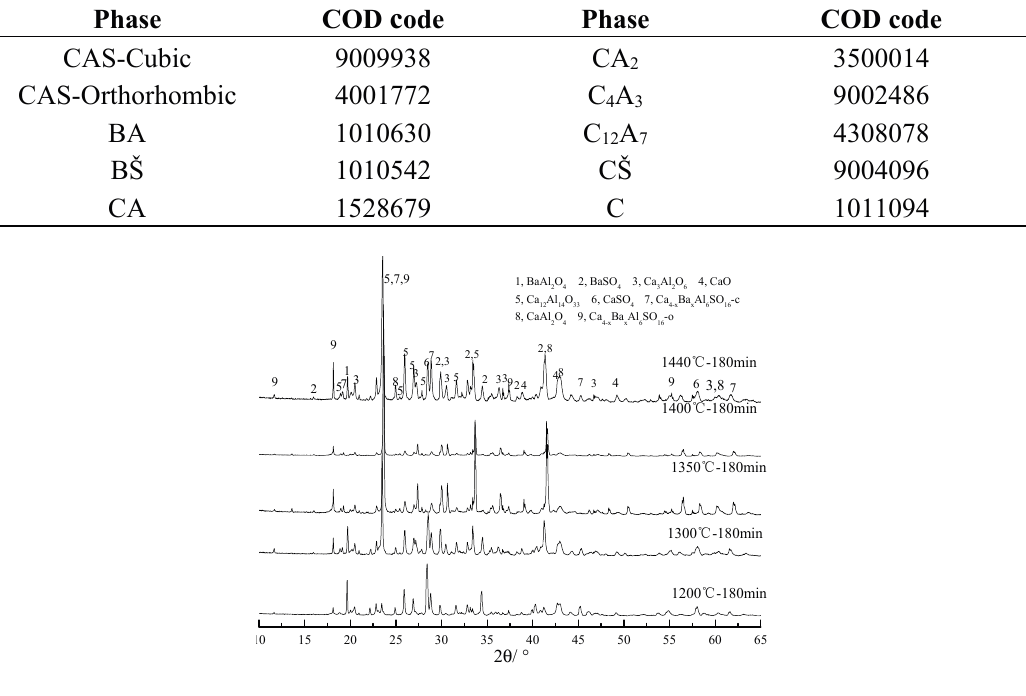
Figure 1. XRD Patterns of calcium barium sulphoaluminate (CBSA) samples sintered at different temperature for 180 min.